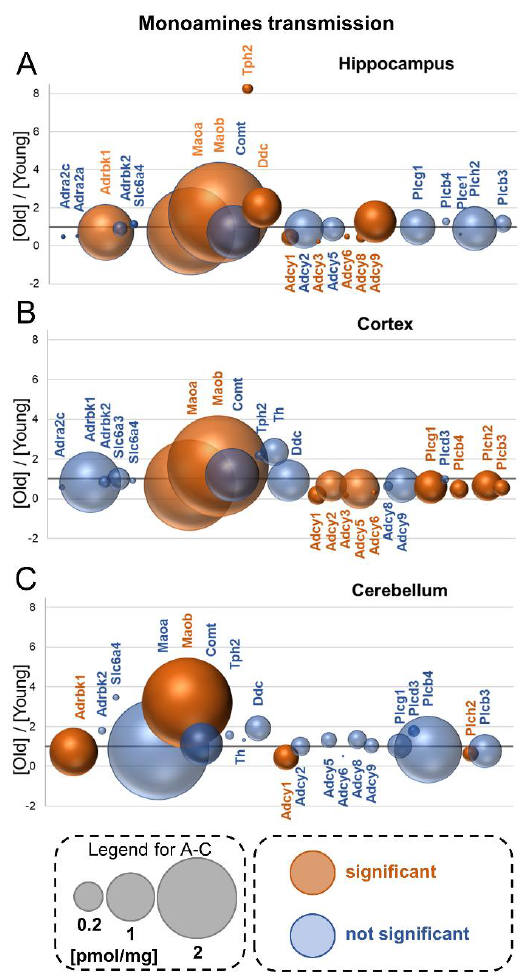
Figure 6. Aging-associated changes in monoamine transmission and metabolism, and in intracellular machinery of signal transduction. Plot shows the ratios of the proteins in old vs. young brain formations in: hippocampus ( A ), cortex ( B ) and cerebellum ( C ). The size of bubbles is proportional to the average protein concentration in the respective old brain structures. Statistically significant differences are shown as the red bubbles.